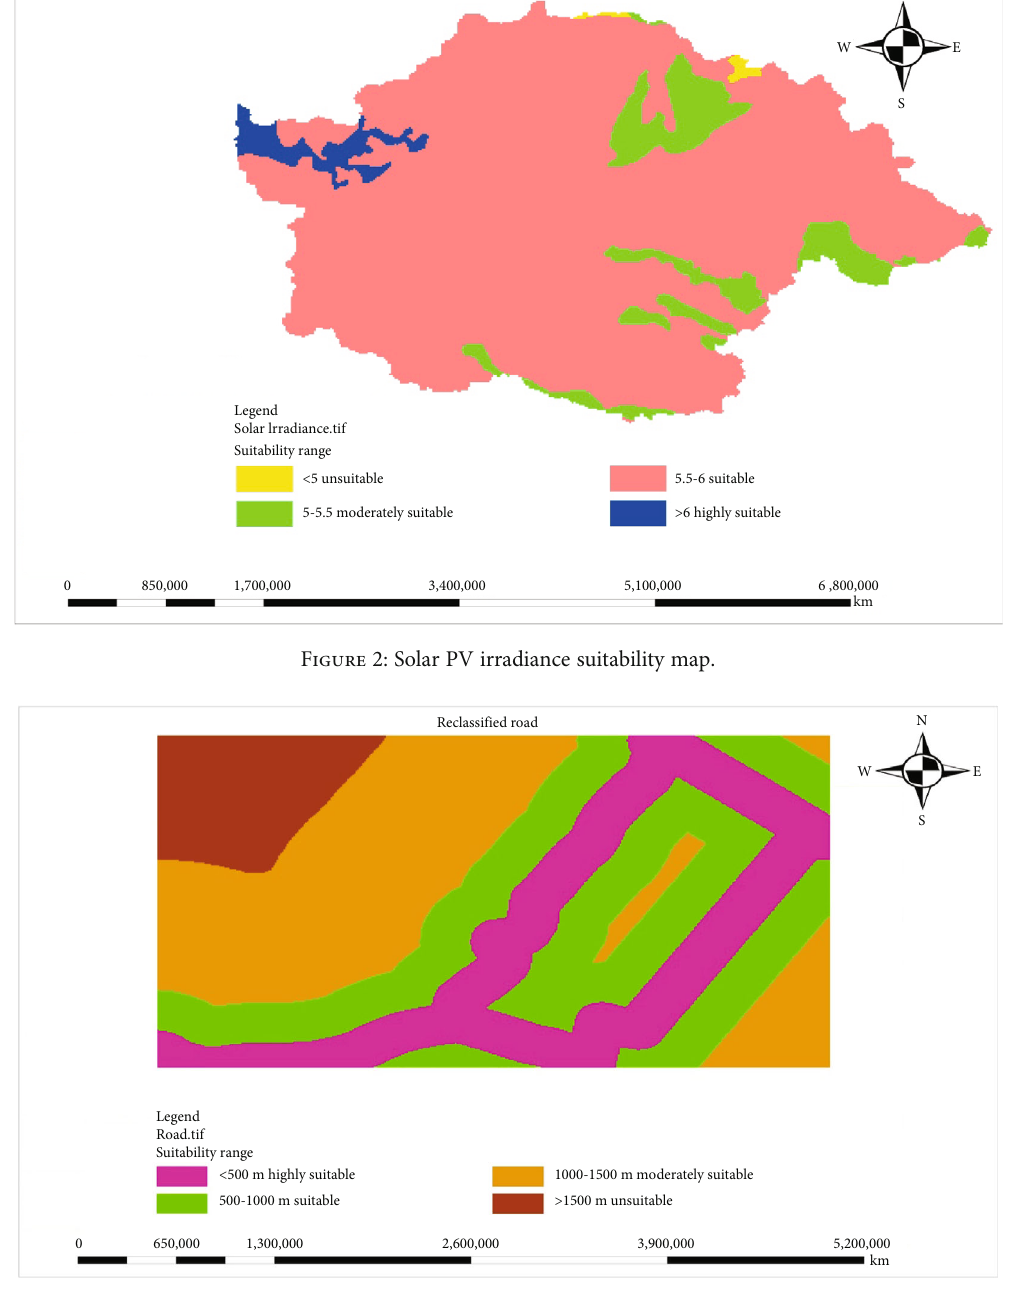
Figure 3: Suitable distance of roads. Table 8: Road reclassi fi